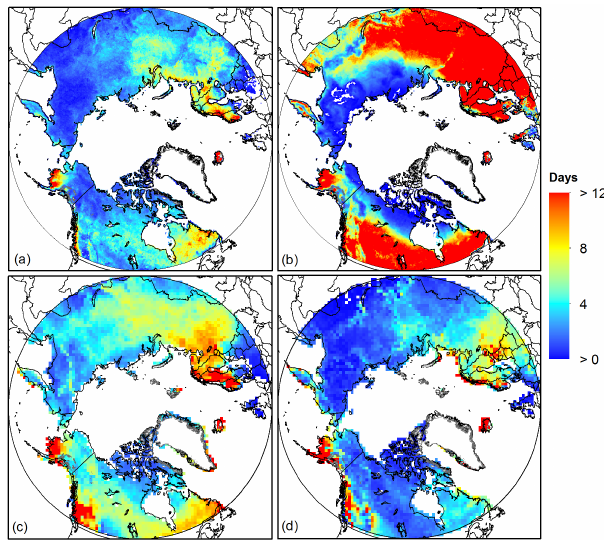
Figure 6. The average annual number of melt days over 1988– 2013 from (a) PMW using a varying winter period; (b) PMW using a fixed winter period (November to April); (c) ERA-Interim; and (d)